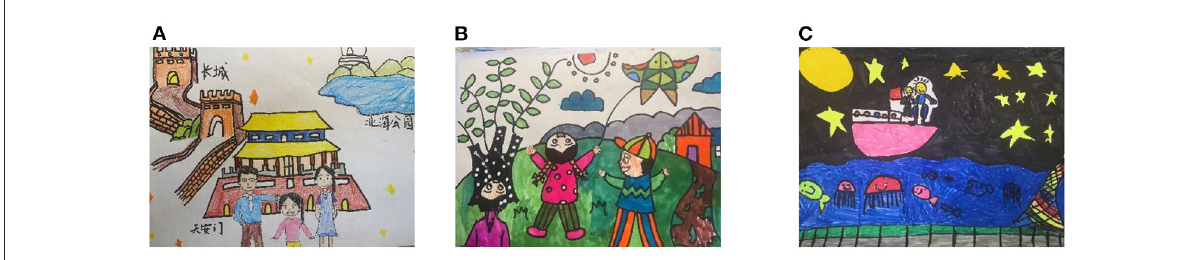
FIGURE4 Tourist scenes in children’s drawings (A) Realistic scenes - A tour in Beijing (5-20X) (1-08Y); (B) Story - based scenes - Flying kites in the park (1-10X); (C) Associative scenes - Night tour